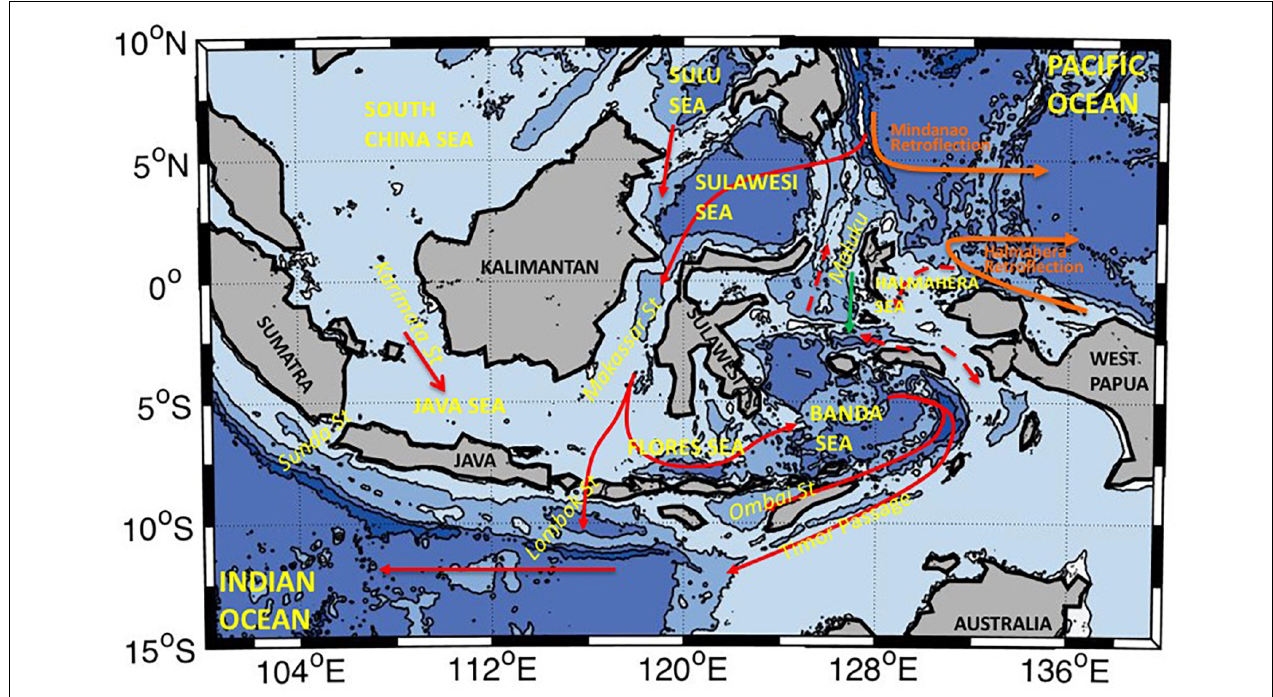
FIGURE 1 | Map of the Maritime Continent, a schematic of the main ITF currents, seas and basins discussed in the text. Upper ocean current pathway is in red, lower pathway in green. Dashed lines indicate uncertain